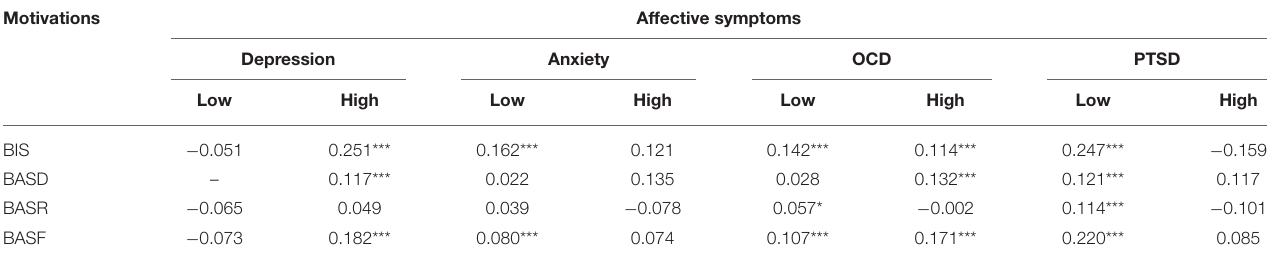
TABLE 7 | Correlations between BIS/BAS subscale scores and severity of mood symptoms. Motivations Affective